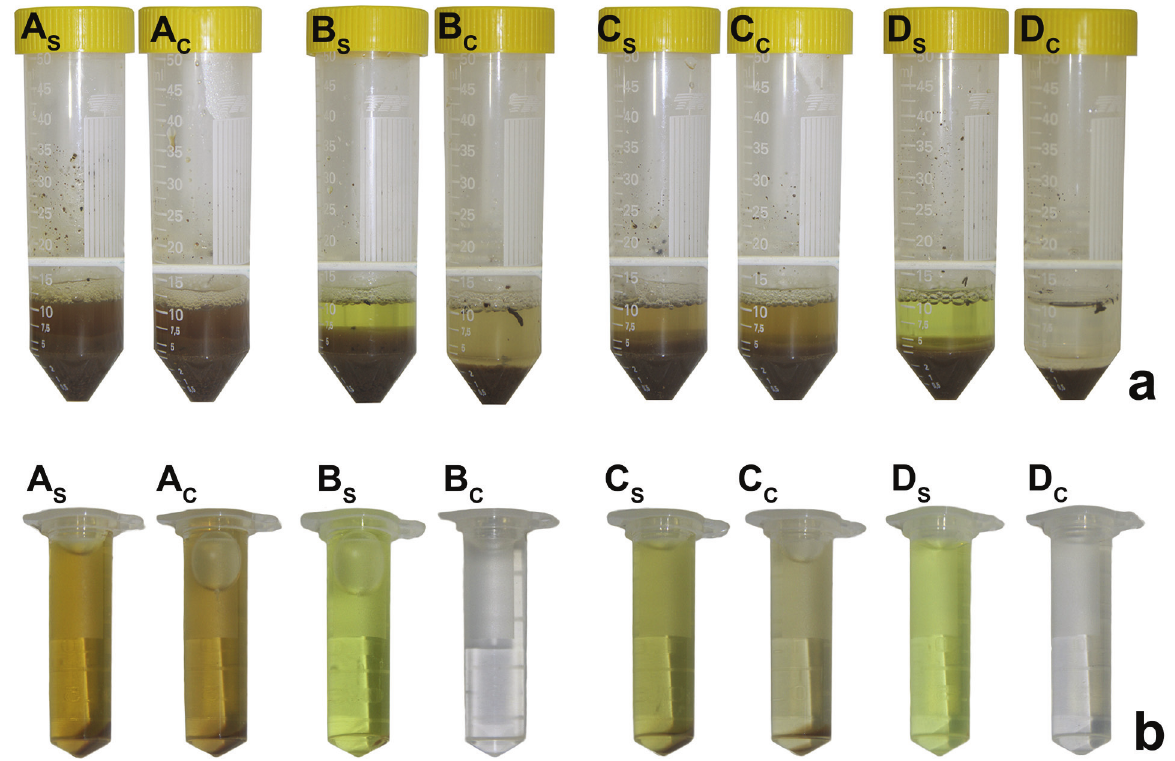
Figure 1 - Interference MUB and low MUB in the staining of control (without) samples and substrate samples in the enzyme extract before ( a ) and after centrifugation ( b ). Substrate samples showed in A C and D . Letters A , A , B and B shows the staining in the native Cerrado (NC) and C c c s c s c identified as A , A , C and C and low MUB is identified as B s c s c